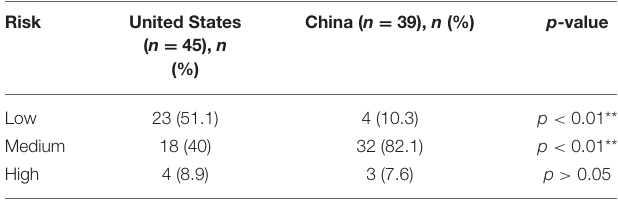
TABLE 3 | The risk assessment of pregnancy and postnatal care mobile apps in the US and China.